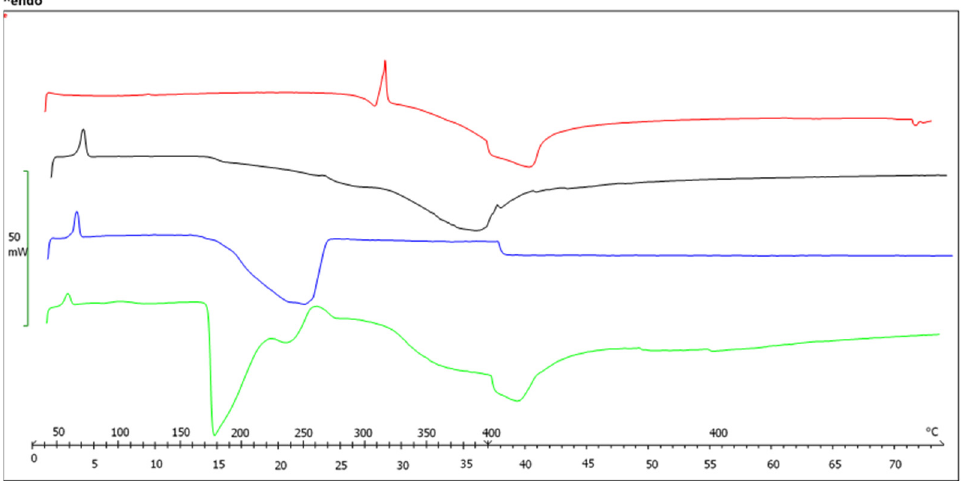
Figure 2. DSC thermograms of original OA (red), Poloxamer 188 (blue), PM OA-P188 1:2 (black), and SEM OA-P188 1:2 (green).